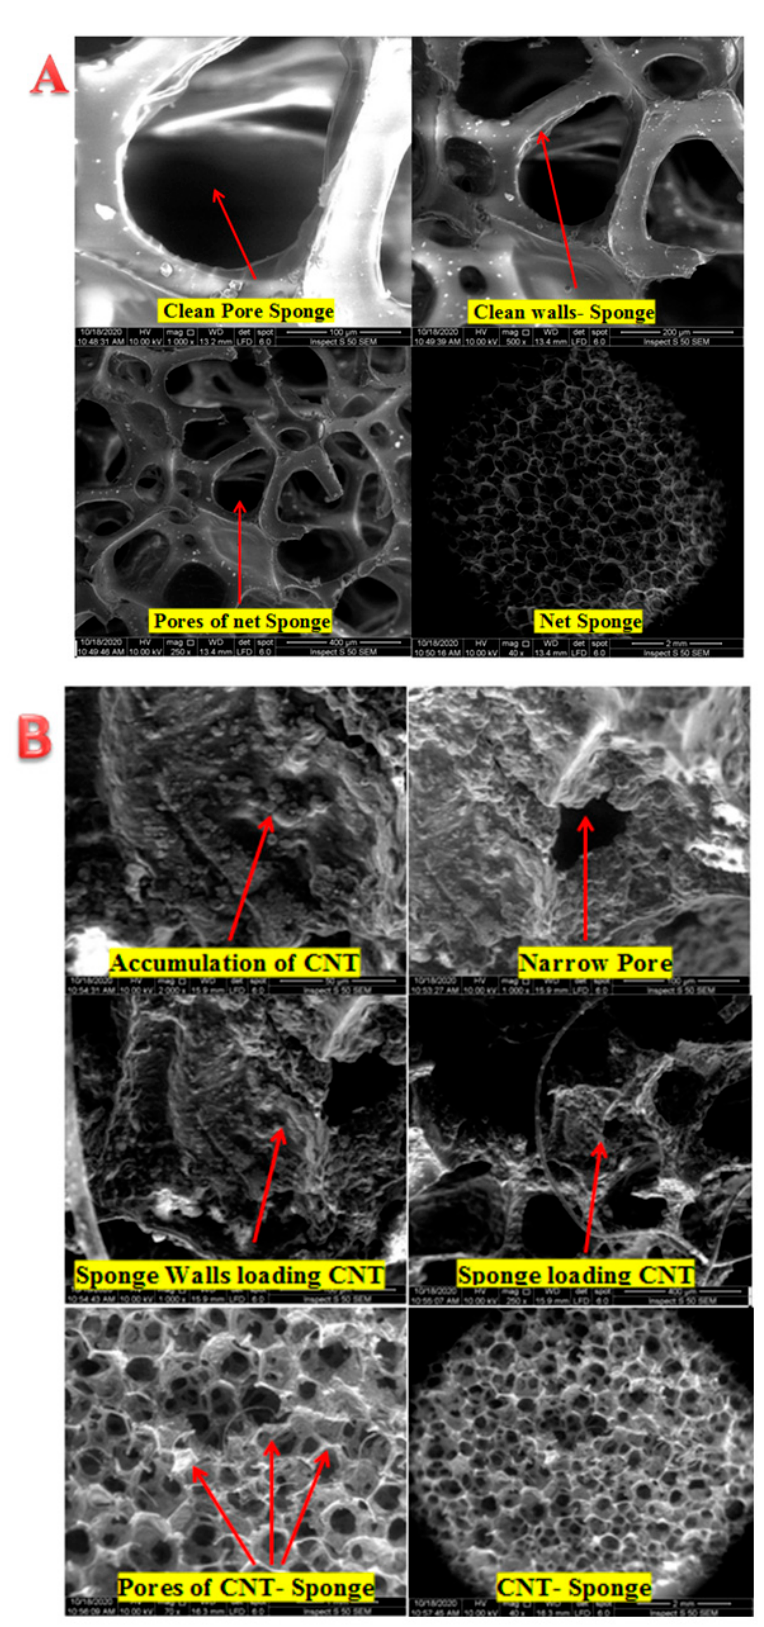
Figure 4. ( A ) SEM images of virgin sponge, ( B ) SEM images of CNTs coated sponge.